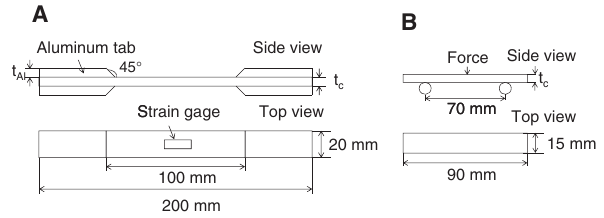
Figure 2 Geometry of the specimen.